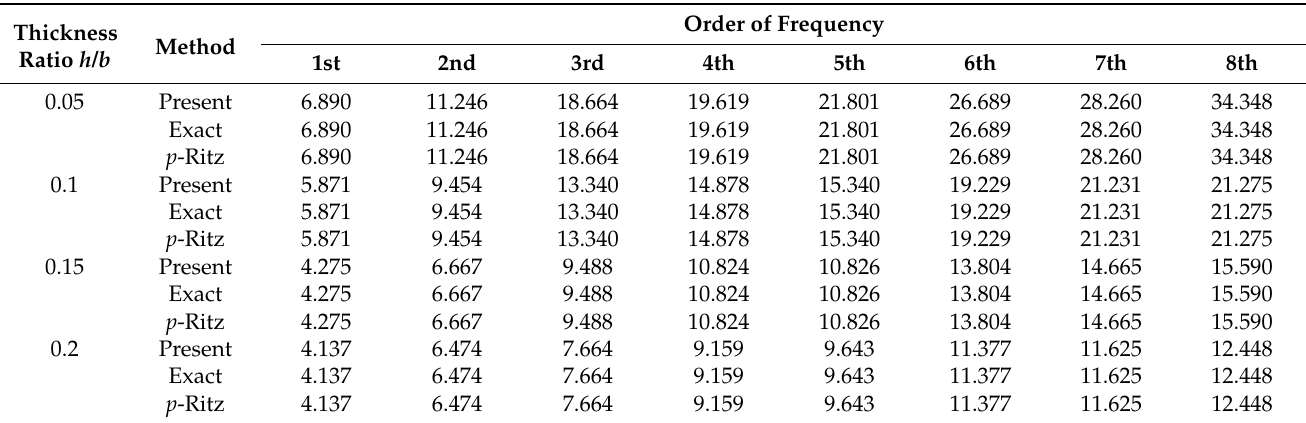
Table 6. The nondimensional frequency Ω for SCSC laminates.